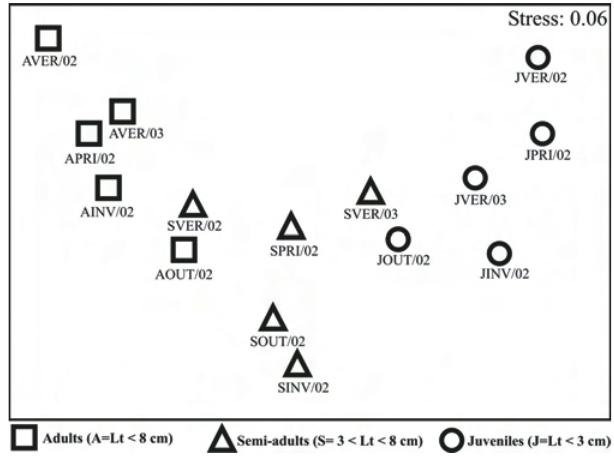
Fig. 5. MDS on the different sizes, sites and seasonal groups. Total length (Lt) categories compared were Juveniles (J = Lt < 3 cm), Semi-adults(S = 3 < Lt < 8 cm) and Adults (A = Lt > 8 cm) and seasons were: VER=summer (December, January and February), OUT=Autumn (March, April and May), INV=Winter (June, July and August) and Spring=PRI (September, October and November).